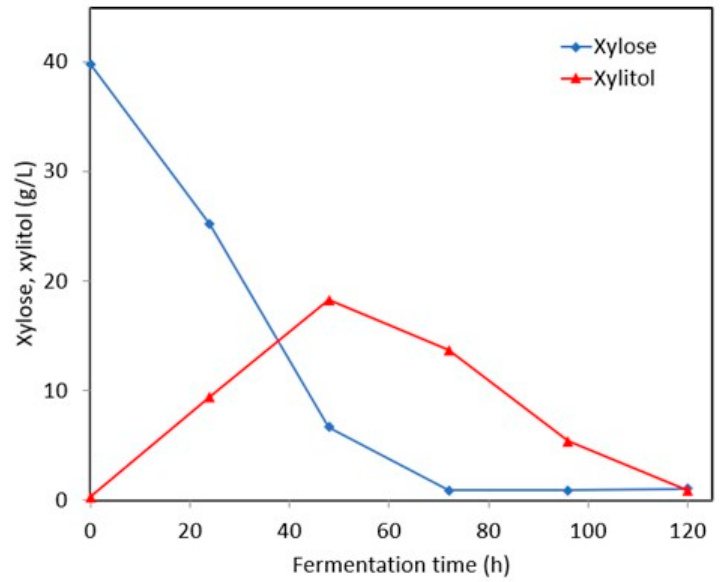
Figure 6. Xylose ( ♦ ) consumption and xylitol ( ▲ ) generation by C. mogii cells recovered from non-detoxified stillage media with xylose supplementation and resuspension in synthetic media. The highest xylitol concentration achieved before it started to decrease was 18.3 g/L and the yield was 0.55 g xylitol/g xylose consumed. This xylitol yield reported is higher than previously reported